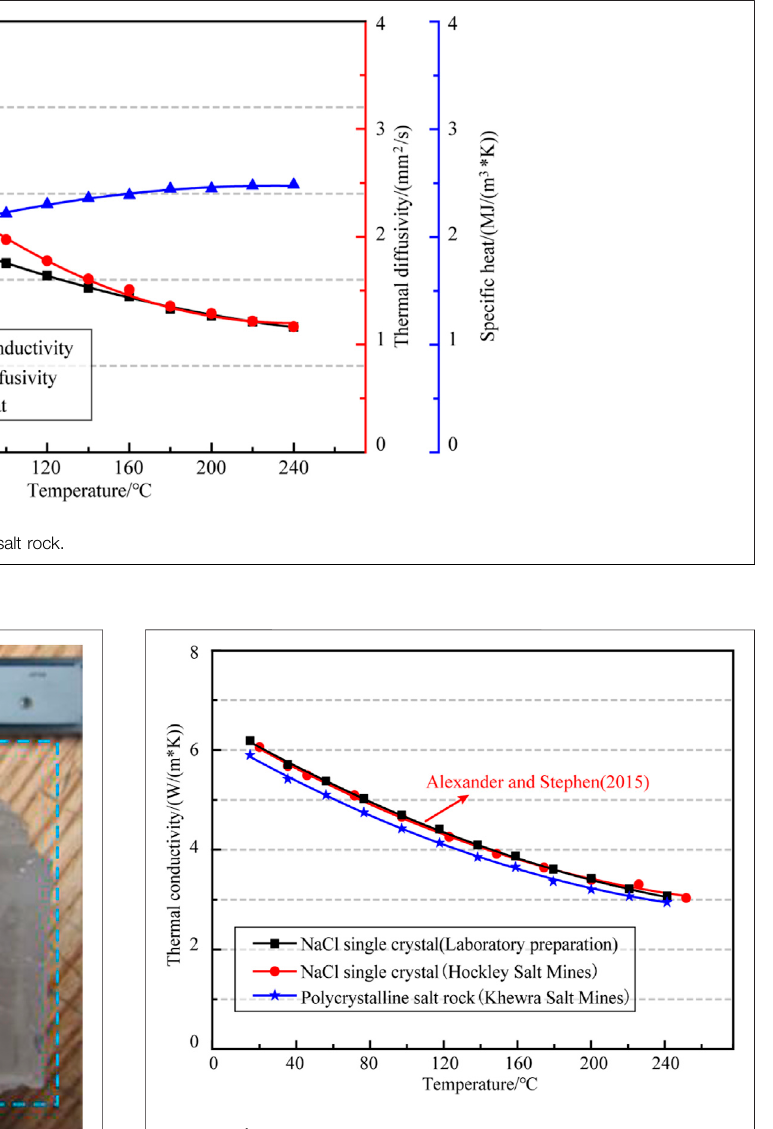
FIGURE 7 | Test results of thermal parameters of different kinds of salt rock